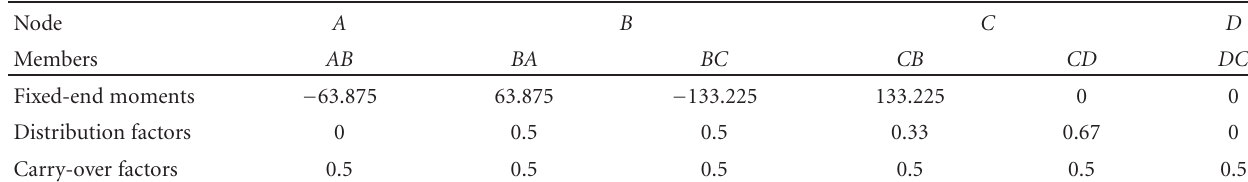
Table 4: Initial moments at the ends of the members and the distribution and carry-over factors for the fourth example.